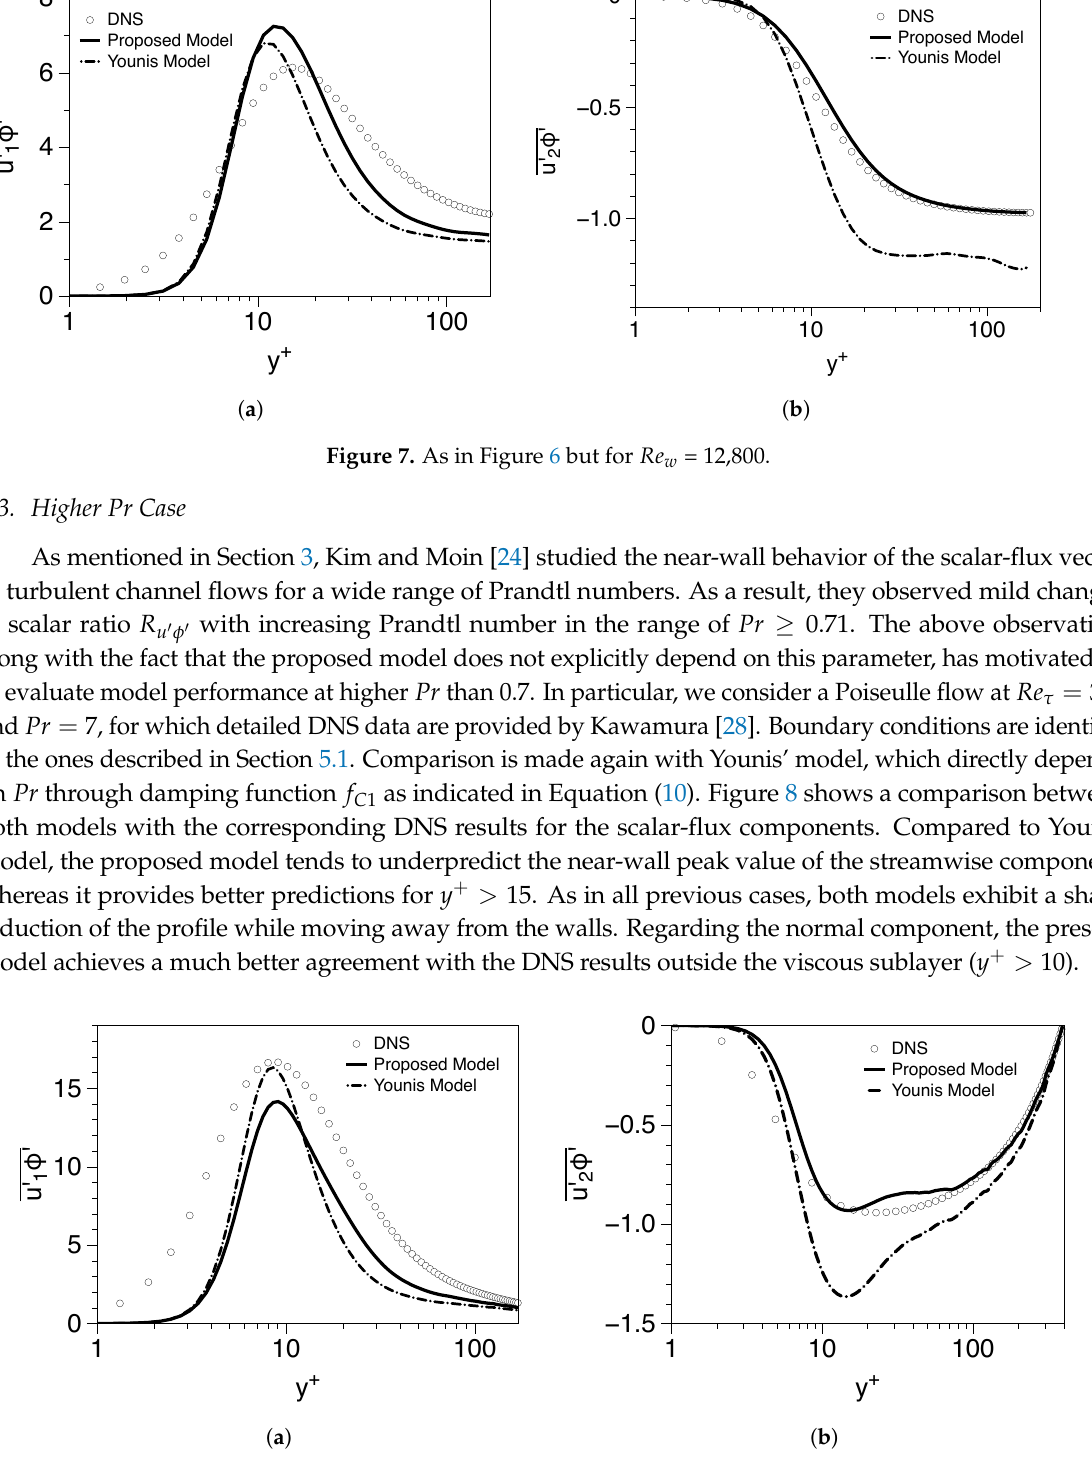
Figure 8. Model predictions for the ( a ) streamwise and ( b ) normal scalar-flux component for a Poiseuille flow at Re τ = 395 and Pr =